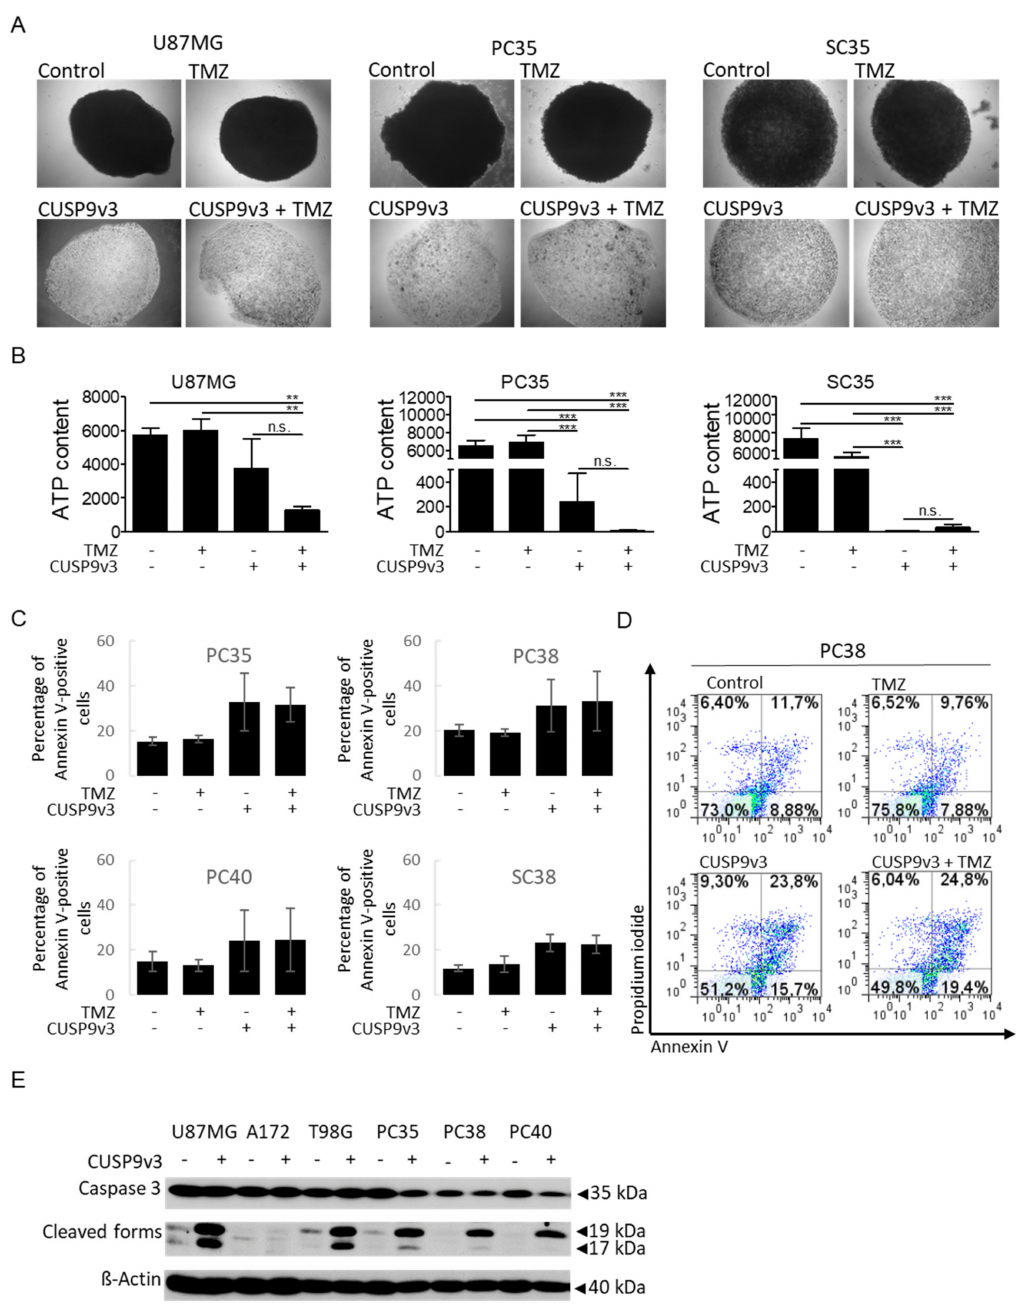
Figure 2. ( A ), Representative microphotographs of U87MG, PC35 and SC35 spheroids treated 1 h after seeding followed by treatments on d7, d9 and d12. 4 × magnification. ( B ), Spheroids of U87MG, PC35 and SC35 glioblastoma cells were grown for 7 d prior to treatments on d7, d9 and d12. CellTiter-Glo ® assays were performed to determine the ATP content of the cells comprising the spheroids. Data are representative for two independent experiments. Columns: mean. Bars: standard deviation. ** p < 0.01, *** p < 0.005. ( C ), PC35, PC38, PC40 and SC 38 cells were treated for 6 h as indicated. Annexin V/PI staining was performed to determine the fraction of Annexin V-positive cells. Data represent three independent experiments. Columns: mean. Bars: standard deviation. ( D ), Representative flow plots of PC38 cells treated for 6 h as indicated prior to staining for Annexin V/Propidium iodide (PI) and flowcytometric analysis. ( E ), U87MG, A172, T98G, PC35, PC38 and PC40 glioblastoma cells were treated with solvent or CUSP9v3 for 6 h. Whole cell extracts were collected and Western blot analysis was performed for Caspase 3 and its cleaved forms. β -Actin served as loading